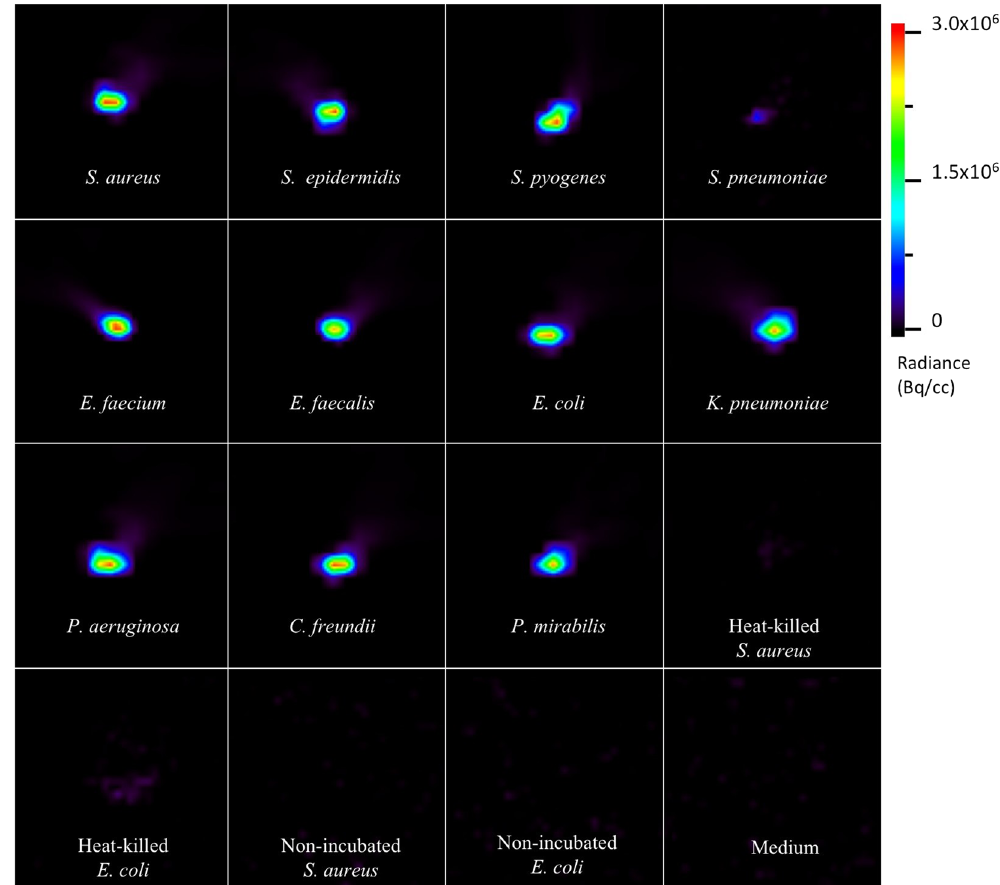
Figure 2. µ PET images of 18 F-FDG uptake by bacterial isolates. Different clinical bacterial isolates were grown to an OD of 1–5 McFarland units in 9 mL of growth medium, pelleted and resuspended in the same volume at 15 min before the incubation with 0.5 ml of 5–10 MBq 18 F-FDG for 5 min. Heat-killed S . aureus or E . coli were obtained by incubating the respective cultures for 30 min at 99 °C. As negative controls, S . aureus or E . coli cells incubated without added 18 F-FDG, or with fresh medium were used. All samples were washed twice in PBS and washed bacterial pellets corresponding to 2 mL culture samples were imaged for 30 min with a µ PET scanner for a qualitative evaluation of the bacterial 18 F-FDG uptake. The scale bar indicates the color map range of Radiance in Bq per cubic centimeter